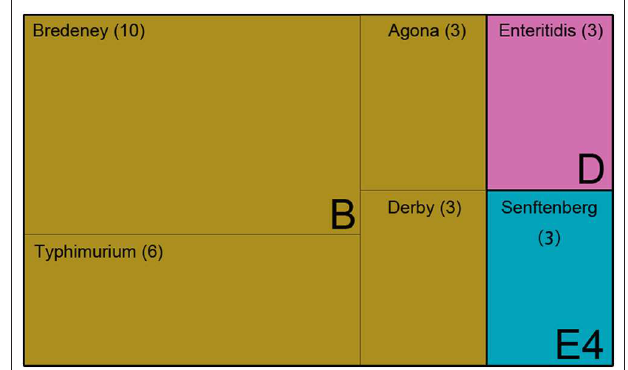
FIGURE 1 | The serotype of 28 Salmonella isolates. Treemap showing 28 isolates identified as serogroups B, D, and E, and subclassified as serovar Bredeney, Typhimurium, Agona, Derby, Enteritidis, and